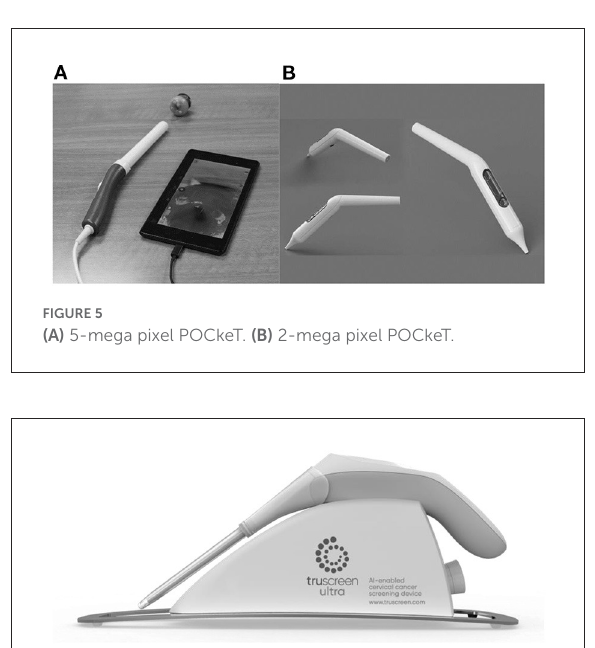
FIGURE6 TruScreen device.